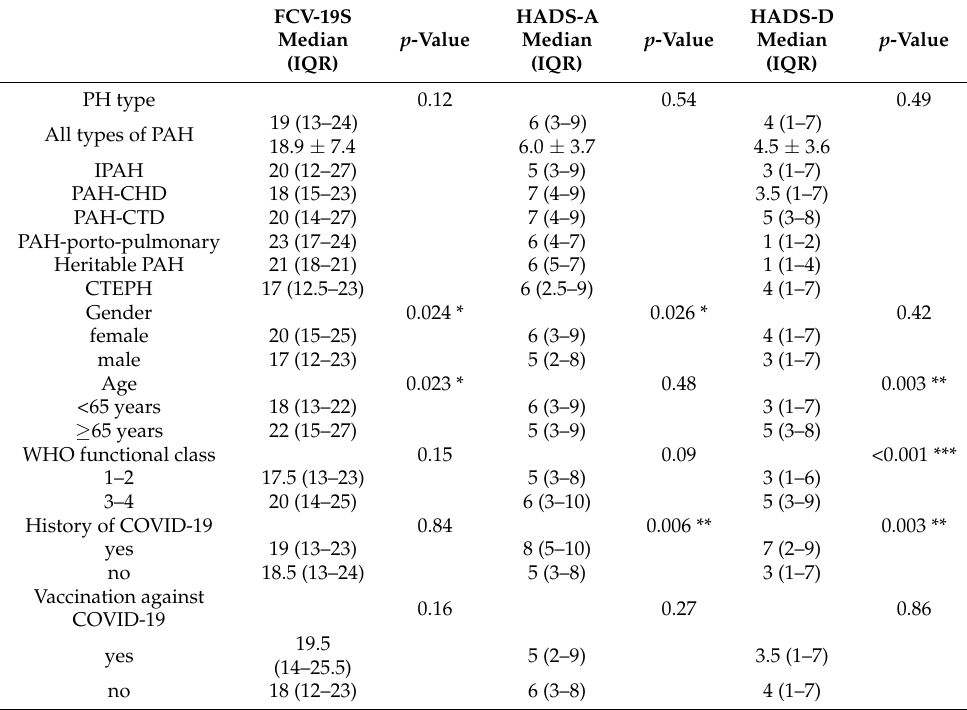
Table 3. Comparison of the level of fear of COVID-19, anxiety (HADS-A) and depression (HADS-D) in the study